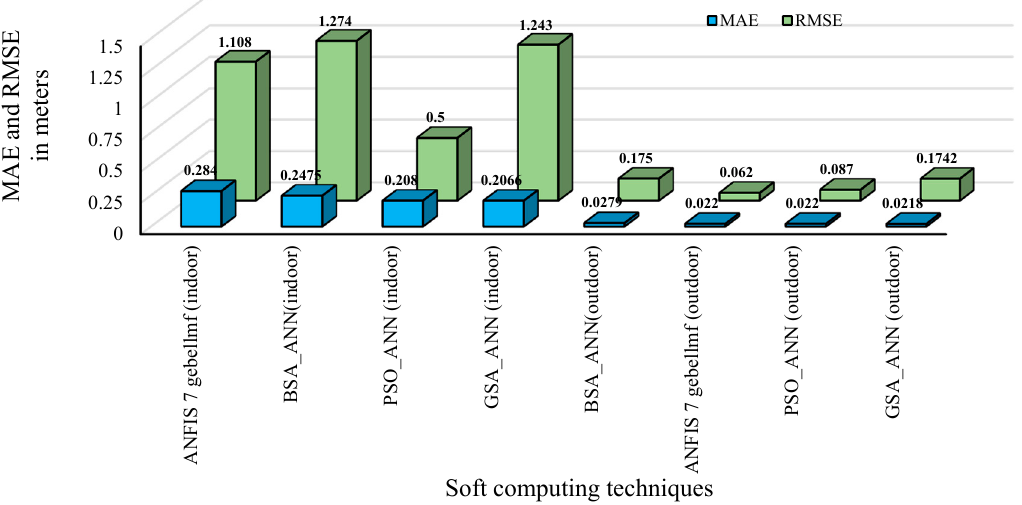
Figure 18. Comparison of the distance estimation error for adopted soft computing techniques for outdoor and indoor velodromes.